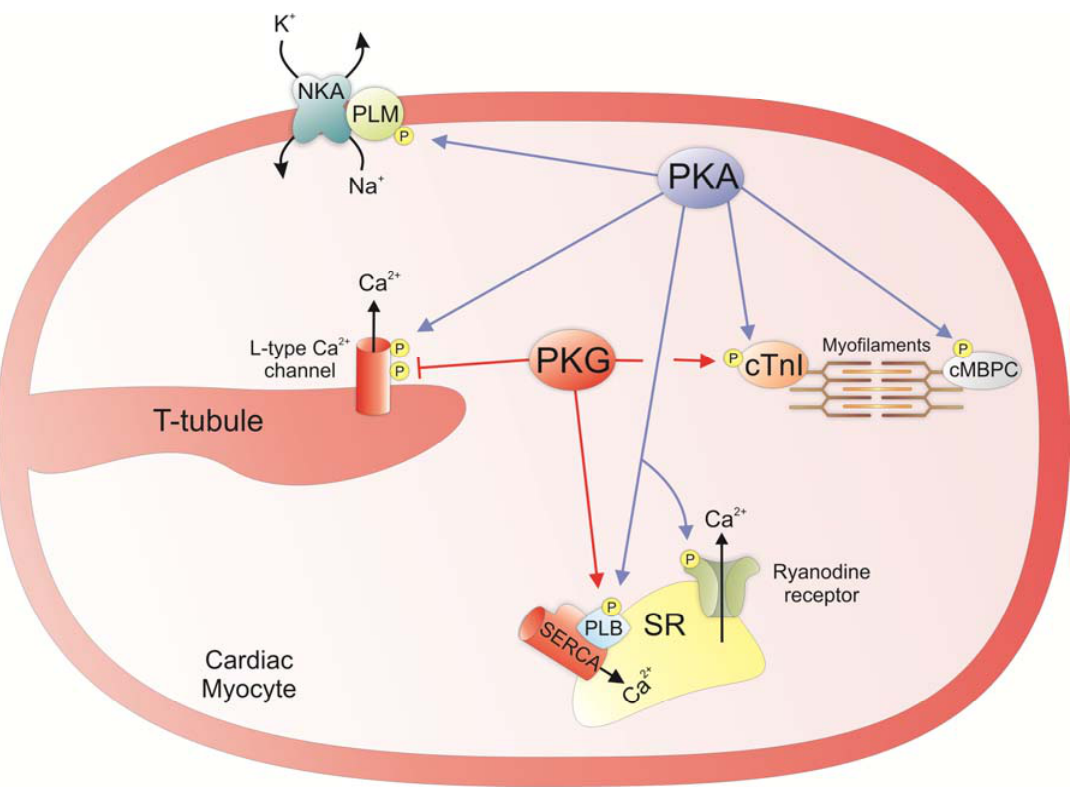
Figure 4. The biochemical targets of PKA and PKG in cardiac myocytes that regulate cardiac